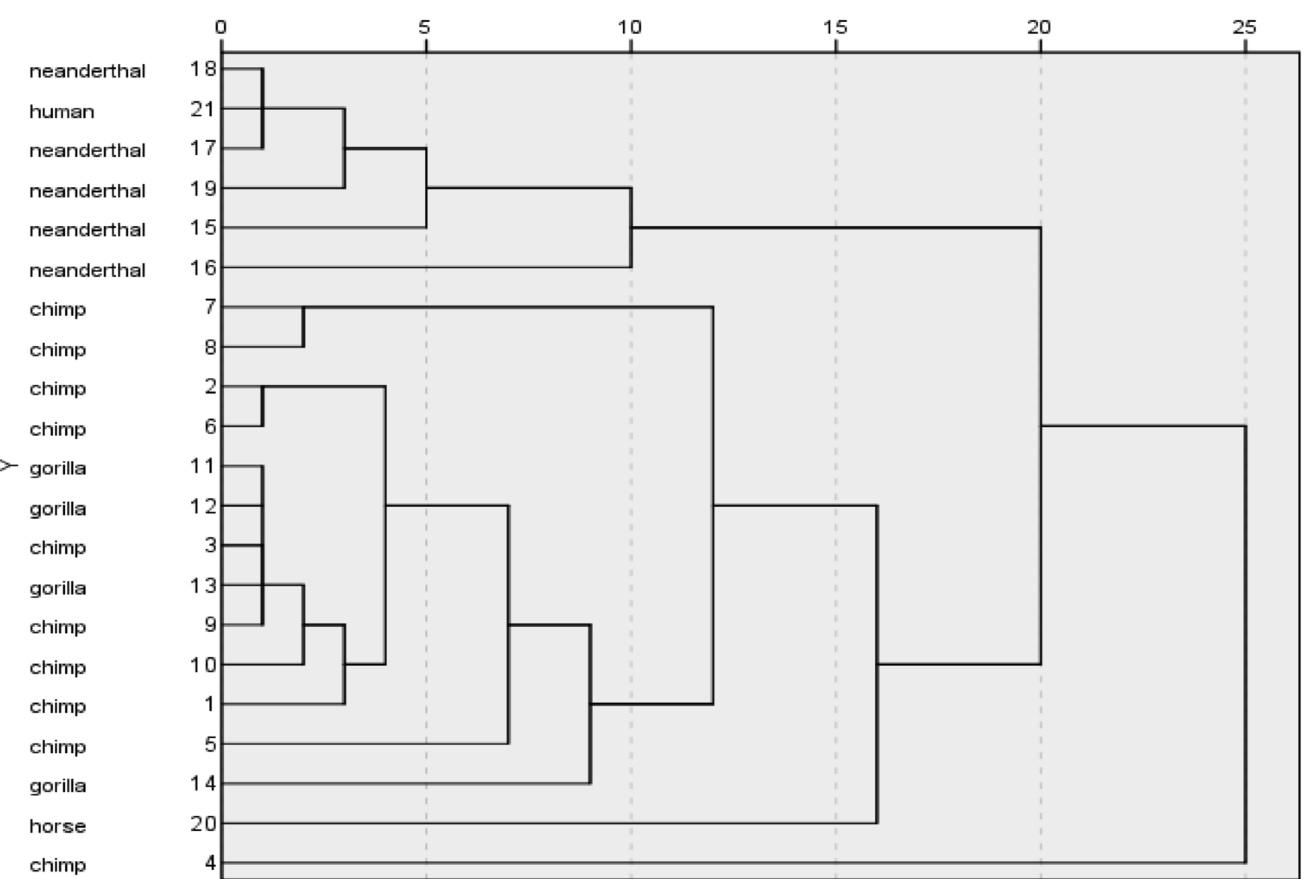
Fig 5. Cluster analysis. The dendrogram generated using the intragroup ’ s method of linkage. It shows groups formed when clustering the NHP samples with 5 neanderthal samples 55 and 1 reference for modern human 56